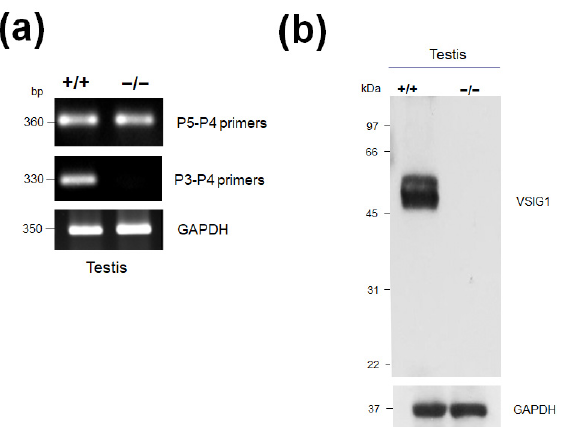
Figure 3. ( a ) RT-PCR analyses of total RNA from the testes of VSIG1 +/+ and VSIG1 − / − mice. The fragments were separated by 1.5% agarose gel electrophoresis. ( b ) Western blot analysis of protein extracts from the testes of the VSIG1 +/+ and VSIG1 − / − mice, using an affinity-purified anti-VSIG1 antibody. No immunoreactive protein corresponding to the 55 kDa VSIG1 was found in the testes of the VSIG1 − / − mice.